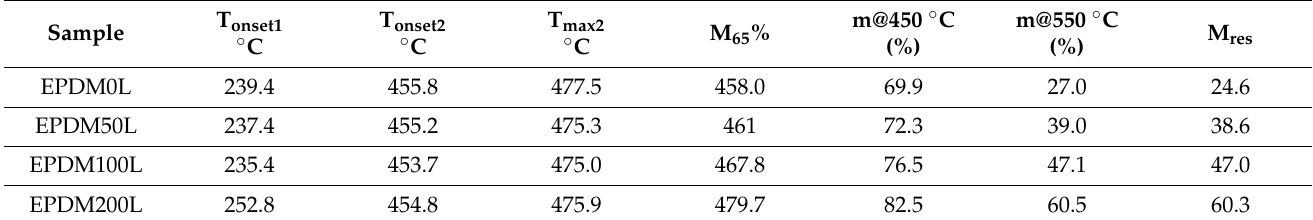
Table 2. Thermogravimetric analysis results of EPDM